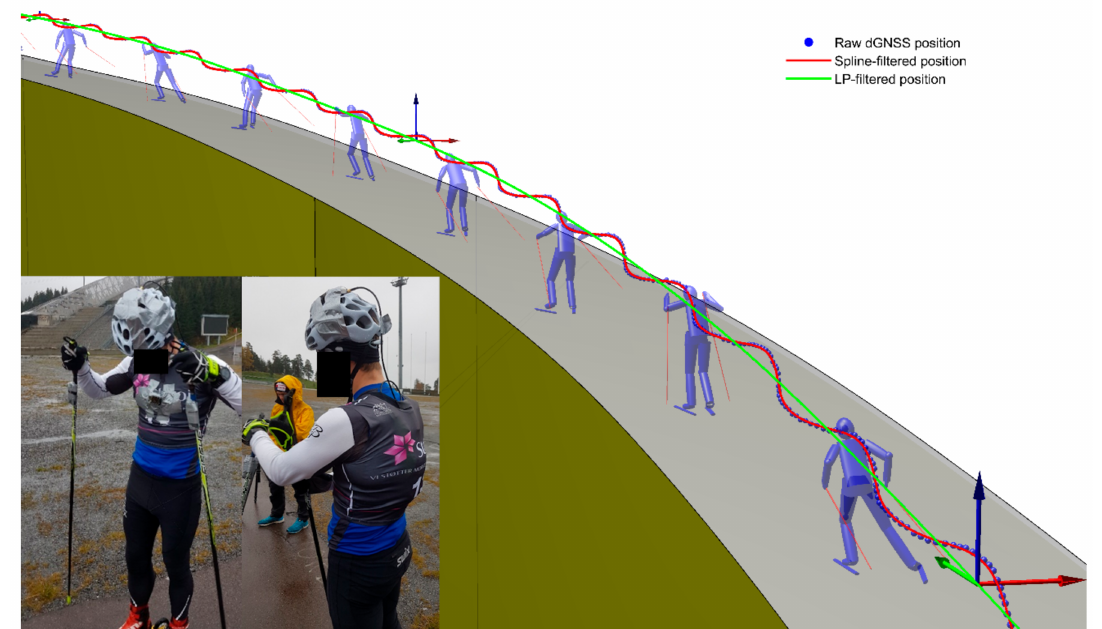
Figure 3. Definition of the local coordinate system (LCS) used to capture the head’s movement. Blue dots are raw dGNSS measurements, red line is the smoothing spline filter, and green line is the trajectory of the smoothing spline after being filtered with a 0.3 Hz low pass filter. The LCS origin followed the low-pass filtered trajectory (green line), and skiing direction was defined as parallel to this trajectory. Sideways was defined as the cross product of unit vectors along the skiing and vertical directions. Picture on the bottom left shows the experimental setup for the outdoor validation experiment (Section 2.2): the GNSS antenna was taped to the skier’s helmet while the receiver was carried in a small backpack under the start bib. A small camera was taped to the chest for validation of the sub-technique